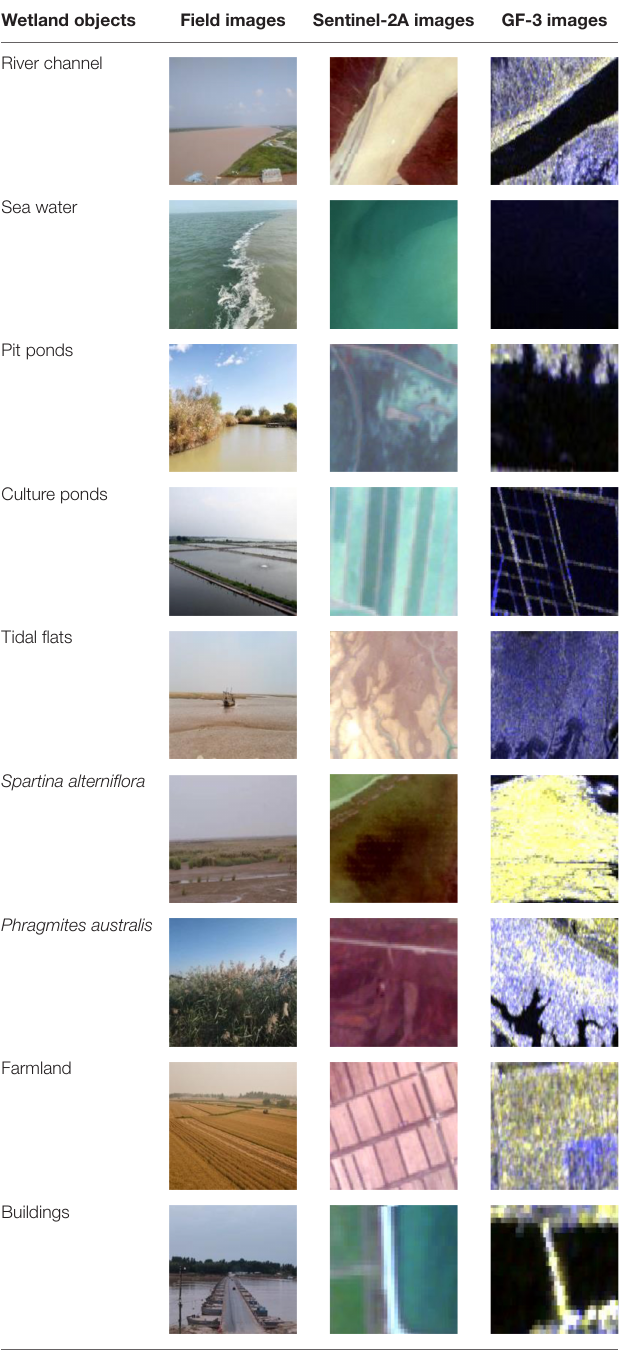
TABLE 1 | The remote sensing interpretation key of main wetland objects in the study area. Wetland objects